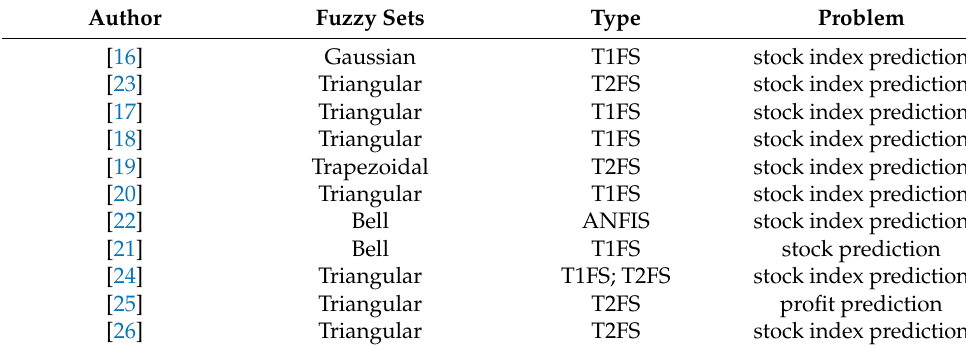
Table 1. Summary of literature